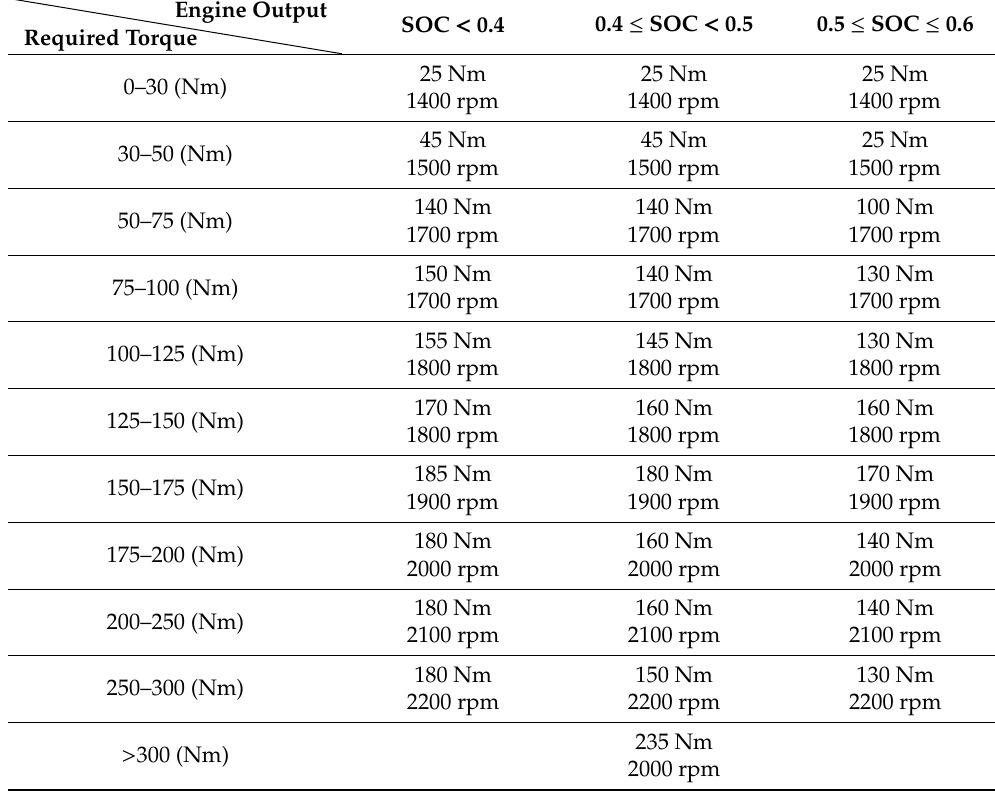
Table 2. Rule-based